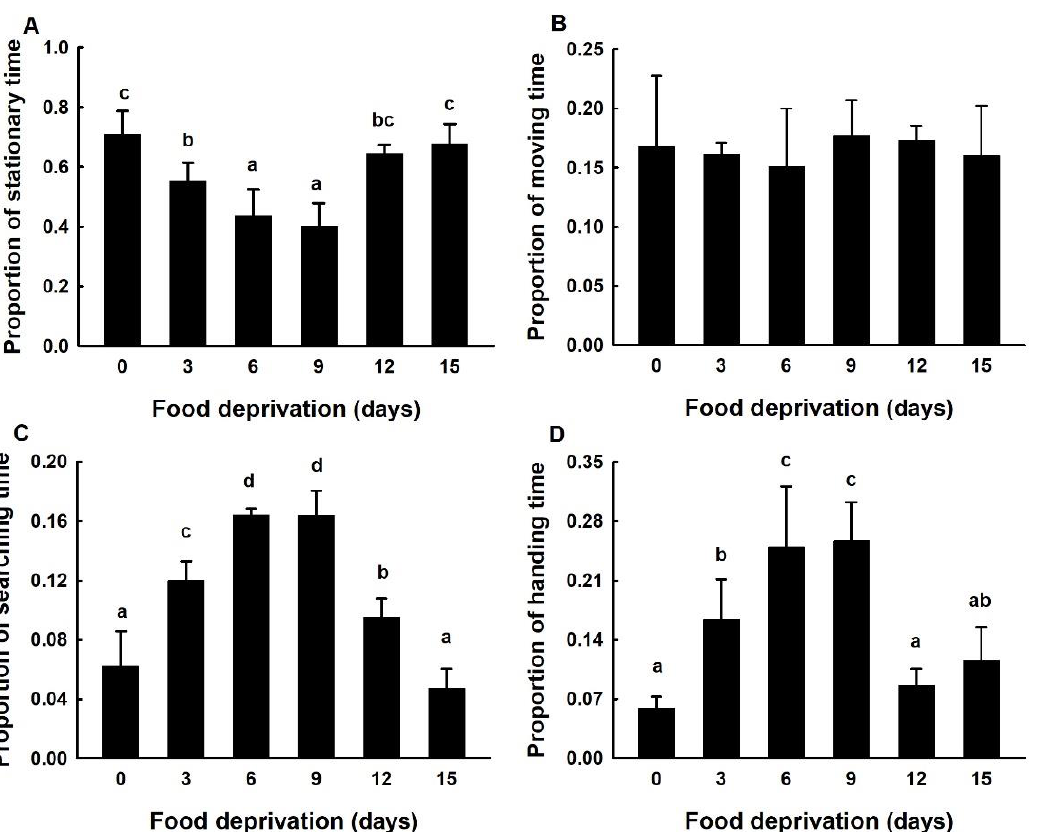
Figure 3. Temporal distribution of the behavior state of E. sinensis under different degrees of food deprivation: ( A ) proportion of stationary time, ( B ) proportion of moving time, ( C ) proportion of searching time, and ( D ) proportion of handing time. Different lowercase letters indicate significant differences among treatments ( p ≤ 0.05).